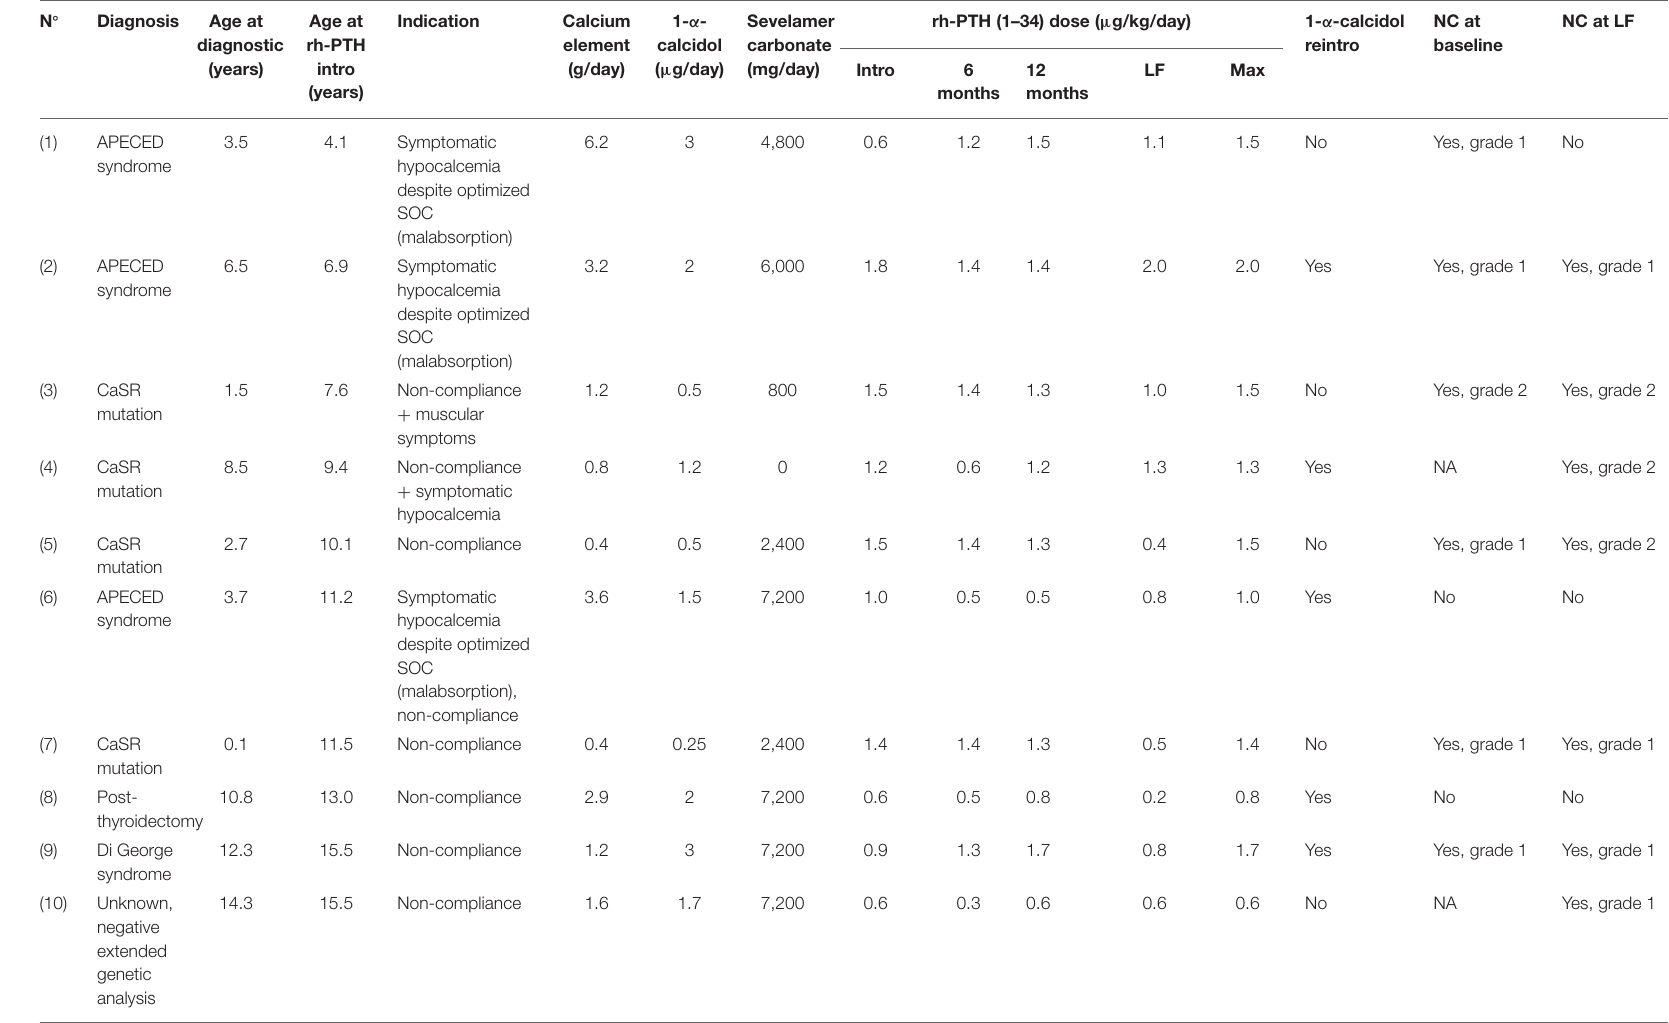
TABLE 2 | Patient characteristics at teriparatide initiation and during